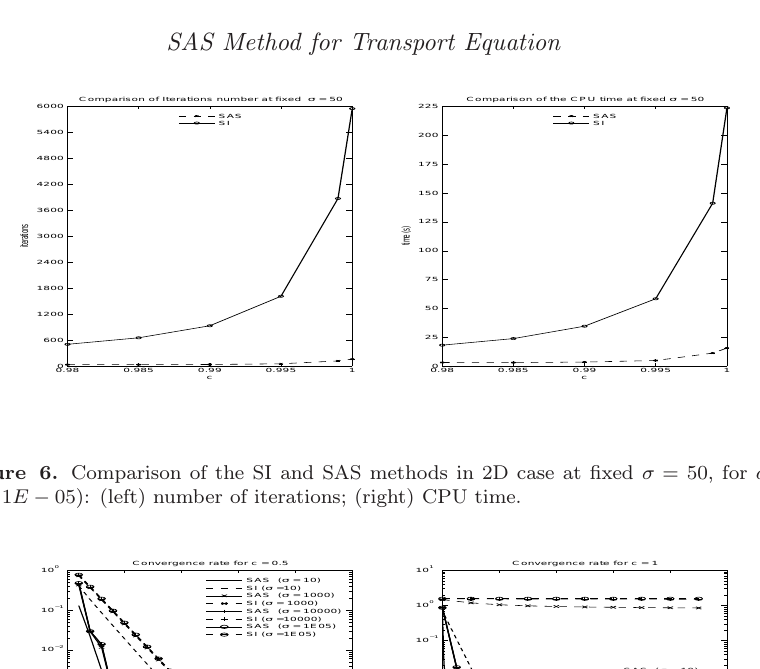
SAS ( σ = 10) SI ( σ =10) SAS ( σ = 1000) SI ( σ = 1000)